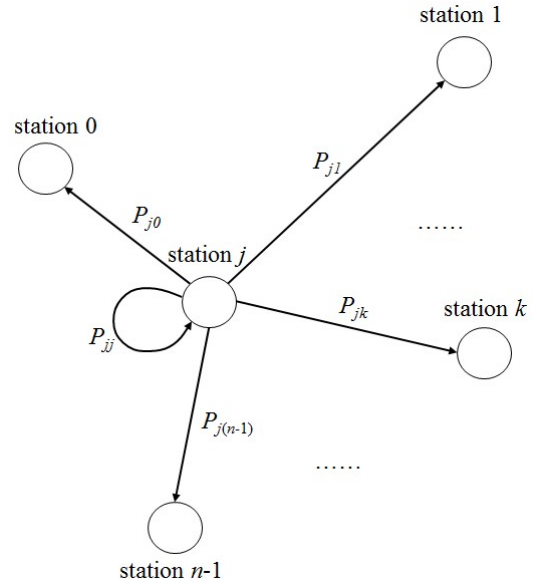
Figure 2. Transition states of station 𝑗 .